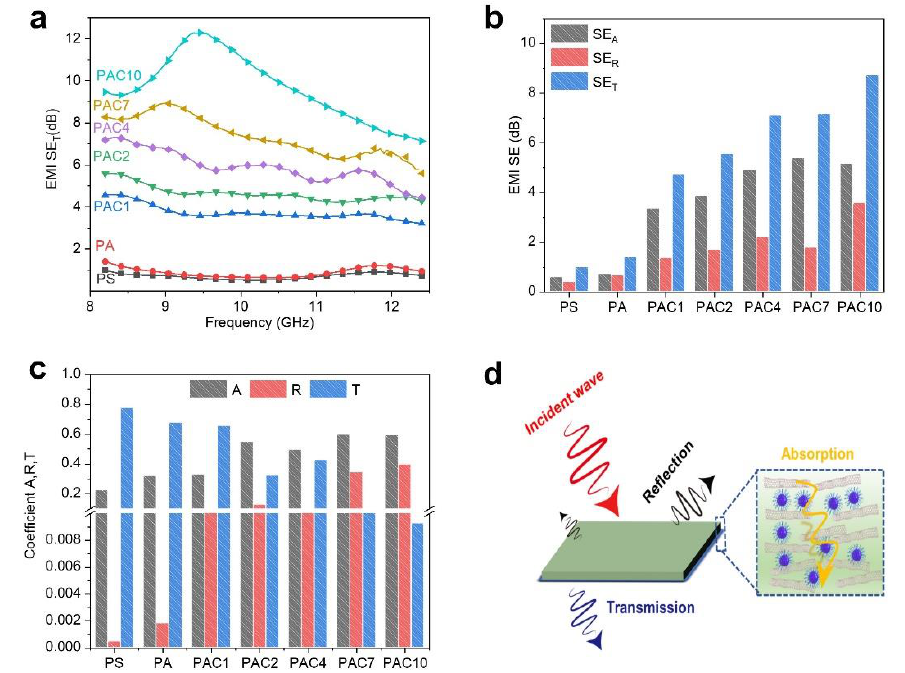
Figure 10. ( a ) EMI SE curves ( b ) the SEA, SER, and SET values; ( c ) the A coefficient, R coefficient, and T coefficient of the PS composites in the X band (8.2–12.4 GHz); ( d ) EMI shielding mechanism of the PS composites.